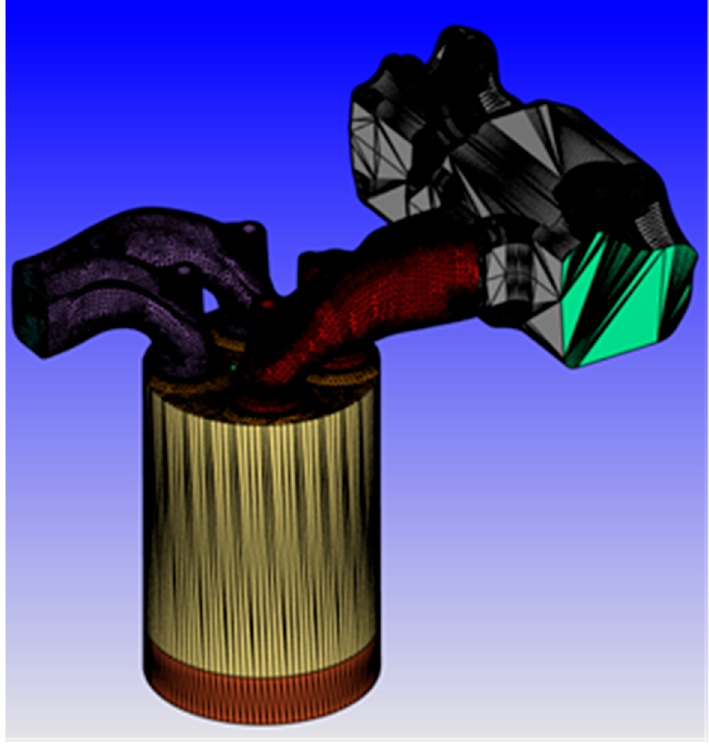
Figure 3. Three-dimensional model of the engine geometry. Table 3. Initial and boundary conditions for CFD simulations.